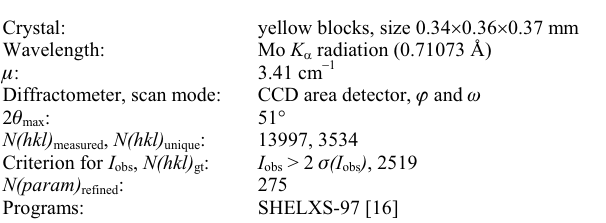
Table 1. Data collection and